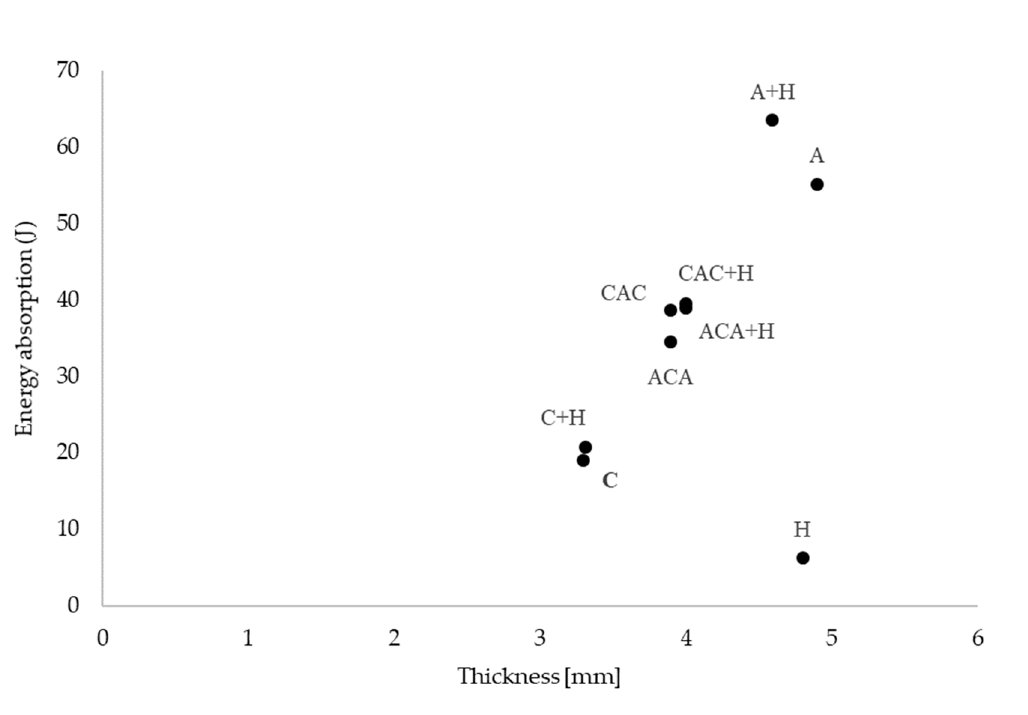
Figure 10. E ff ect of composite thickness on energy Figure 10. Effect of composite thickness on energy absorption.